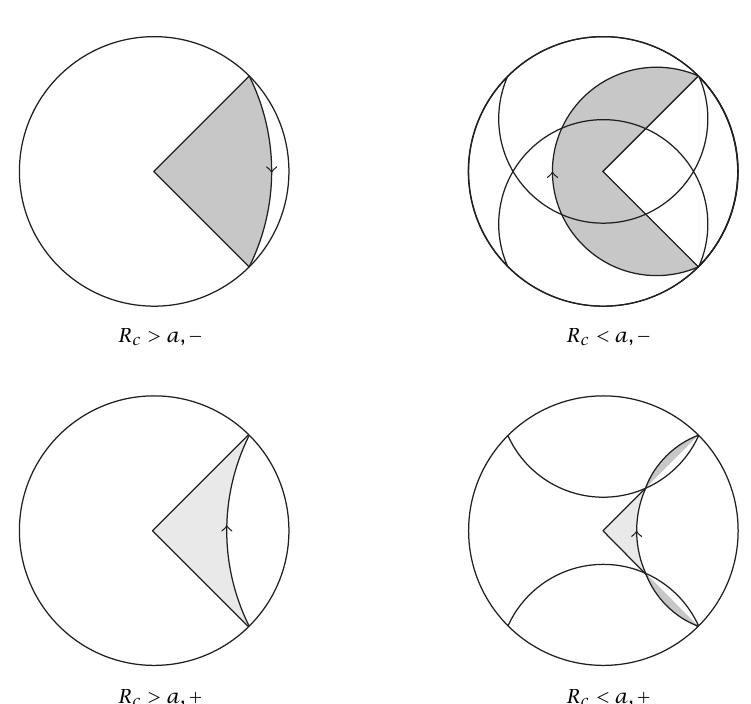
Figure B.2 . The geometry of the “ + ” orbits.